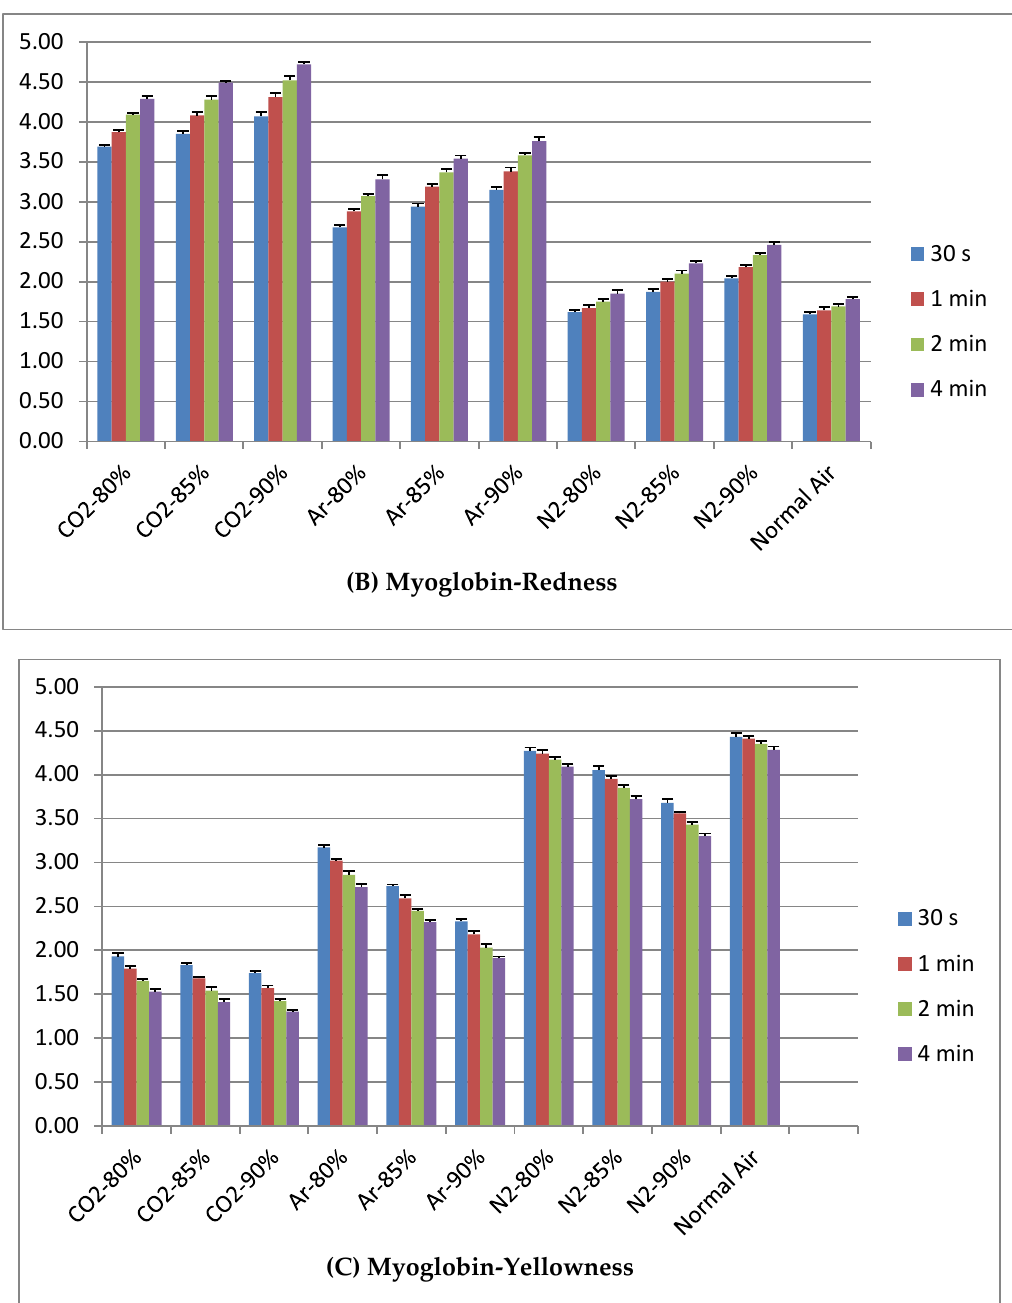
Figure 2. Effect of high concentration levels of different gas exposing conditions on Myoglobin solution at different duration of time.